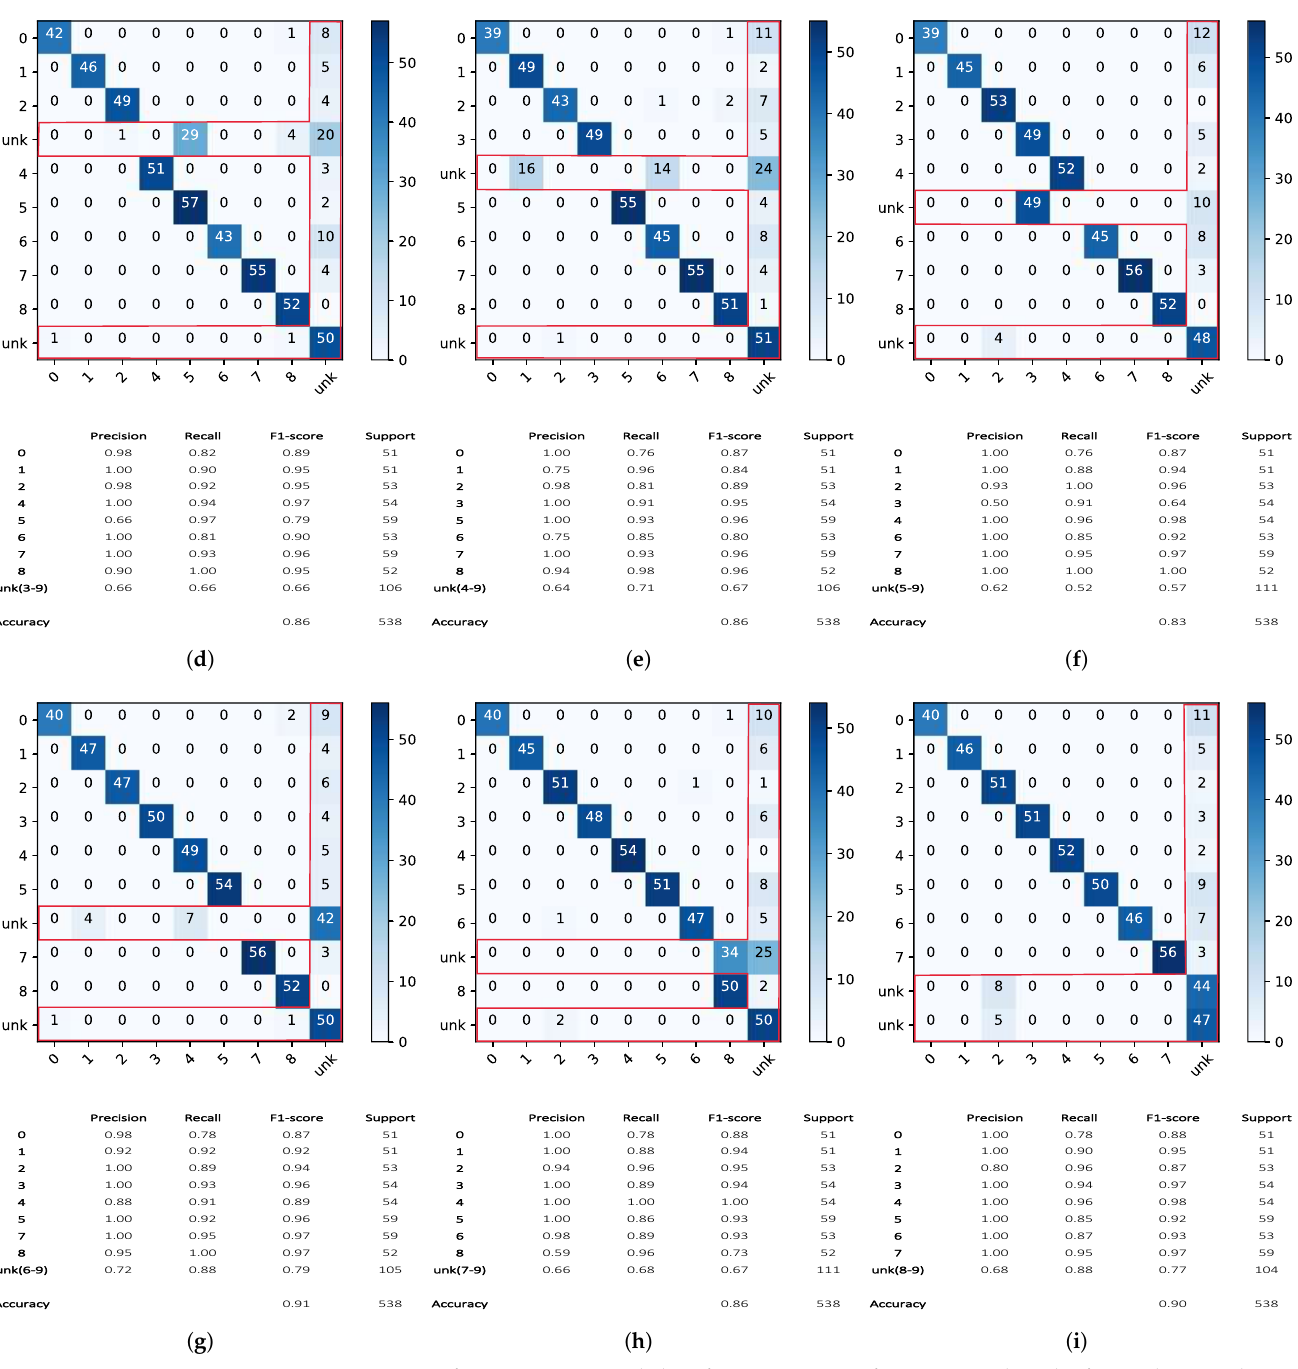
Figure 9. Confusion matrices and classification reports of Openmax when the first unknown class is changed while the second one is fixed: from ( a – i ) correspond to scenarios of having two unknown classes of ( k ,9) where k = 0, ...,